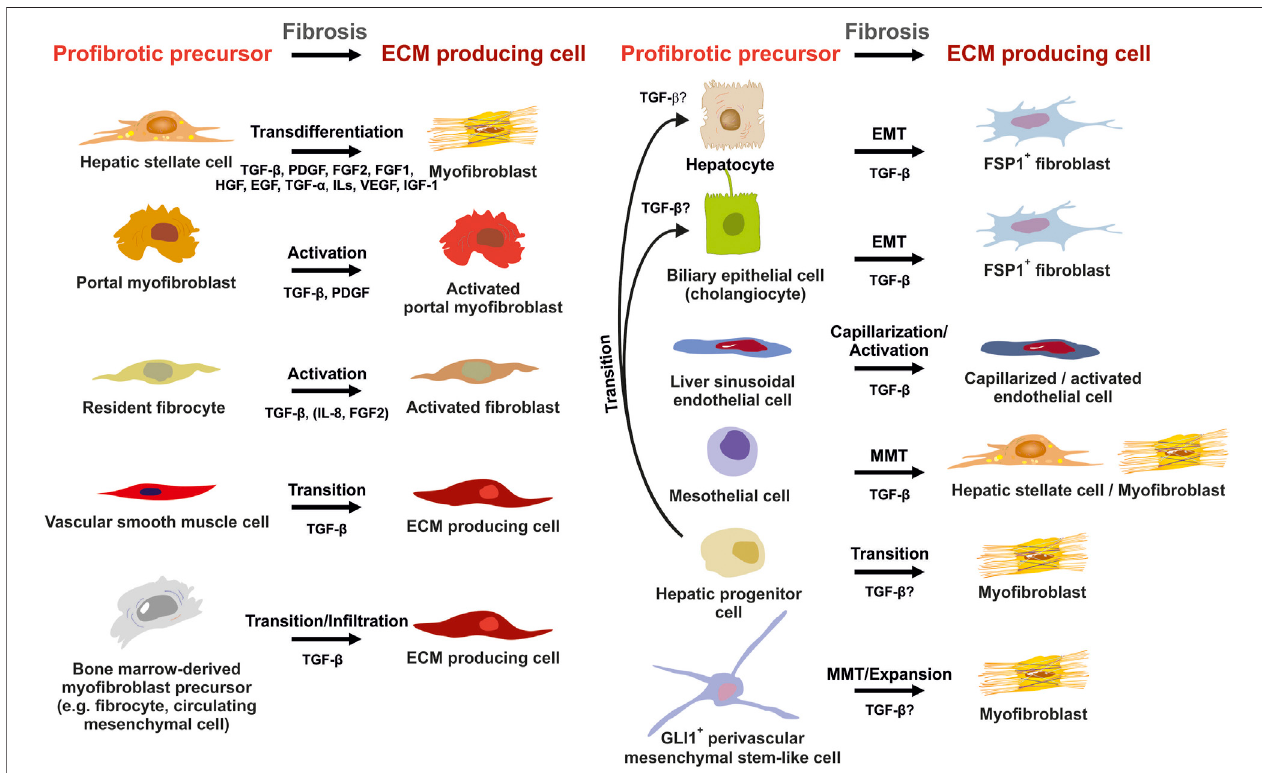
FIGURE 6 | Potential sources of extracellular matrix (ECM) producing cells in liver fi brosis. ECM producing cells during hepatic fi brosis can originate from many sources. Hepatic stellate cells (HSCs) that transdifferenatiate into myo fi broblasts (MFBs), activated portal myo fi broblasts and activated resident fi broblasts are rich sources of ECM. In addition, several other cell types that become activated, in fi ltrate the liver, or originate by diverse transition processes are suitable to express large quantities of ECM. Major pathways driving establishment of myo fi brogenic features are indicated for each progenitor. Abbreviations used are: ECM, extracellular matrix; EGF, epithelial growth factor; EMT, epithelial-to-mesenchymal transition; FGF1/2, fi broblast growth factor 1/2; GLI1, glioma-associated oncogene homolog 1; HGF,hepatocytegrowth factor; IGF-1,insulin growth factor-1; IL, interleukin;MMT, mesothelial-to-mesenchymal transition; PDGF, platelet-derived growth factor; TGF- α / β , transforming growth factor- α / β ; VEGF, vascular endothelial growth factor. For details see text.